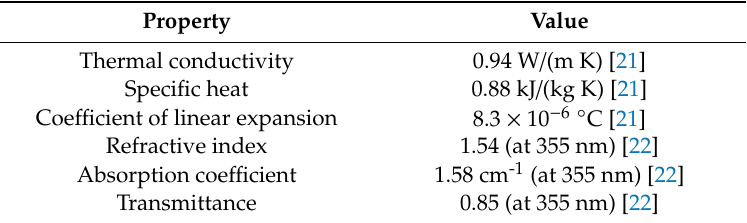
Table 2. Thermophysical and optical properties of the soda lime glass.